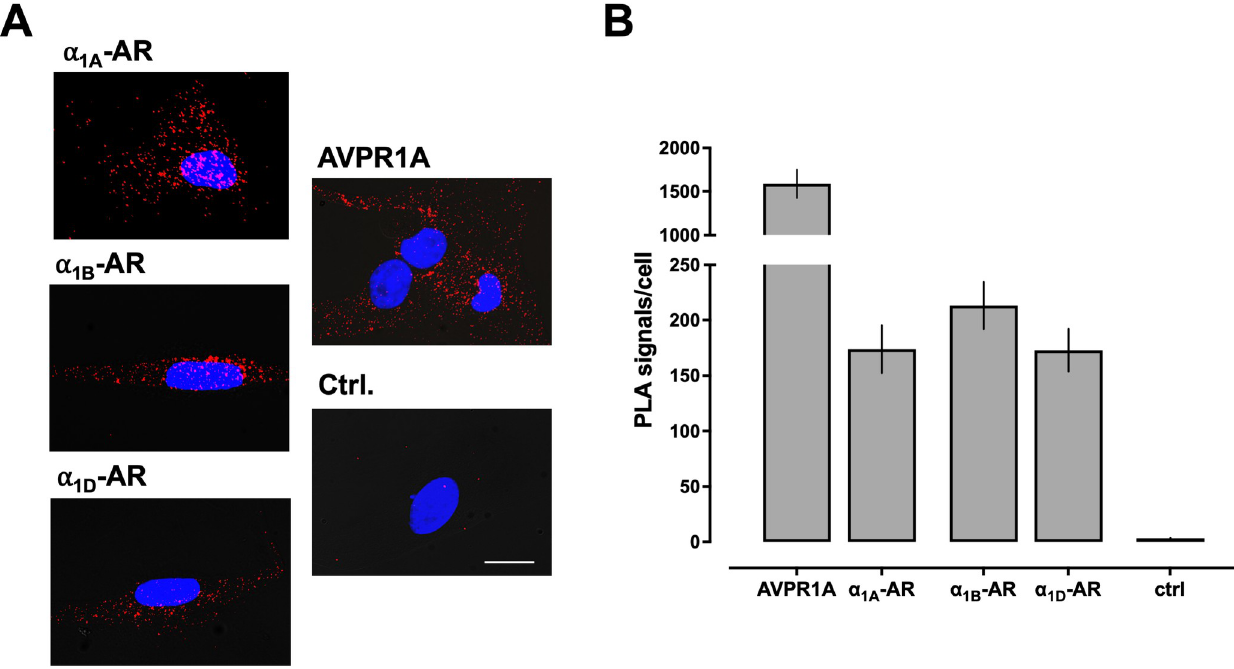
Fig 1. Detection of a 1A/B/D -AR and AVPR1A in hVSMCs. ( A ) Representative PLA images for the detection of individual receptor protomers. Images show merged PLA/4 0 ,6-diamidino-2-phenylindole dihydrochloride (DAPI) signals. Ctrl: Omission of primary antibody. Scale bar = 10 μ m. ( B ) Quantification of PLA signals from n = 4 independent experiments with n = 10 images per